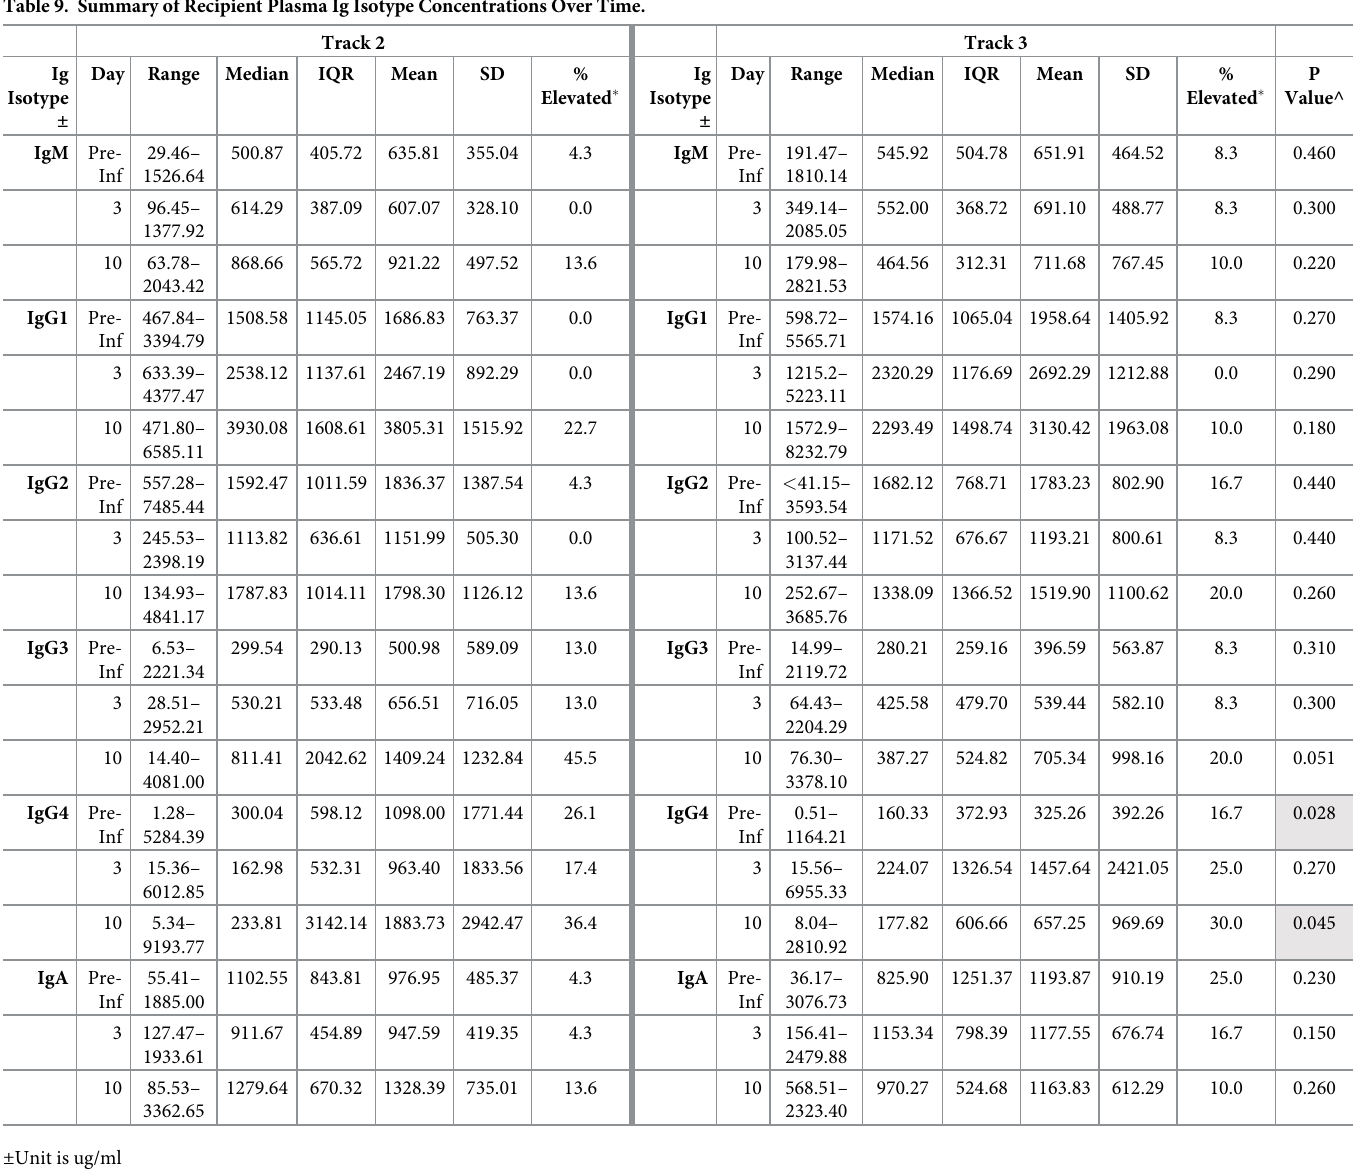
Table 9. Summary of Recipient Plasma Ig Isotype Concentrations Over